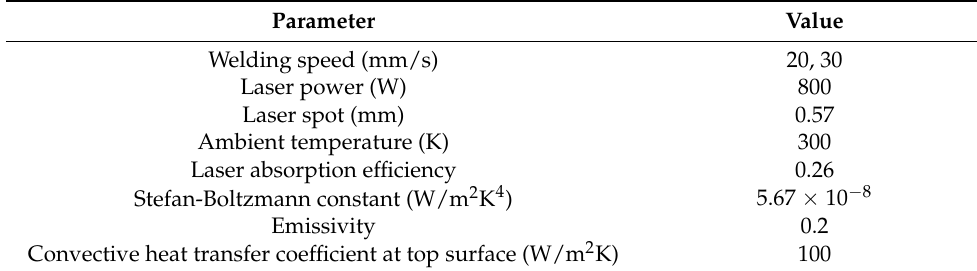
Table 4. Welding parameters used in the